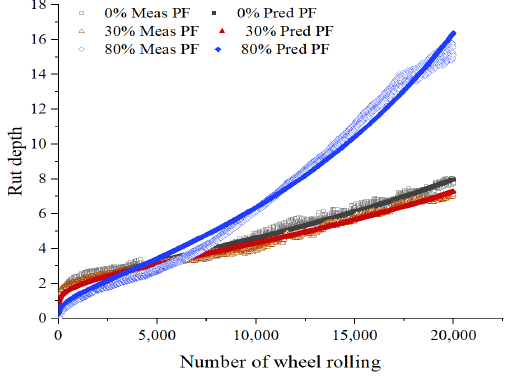
Figure 19. HWTT Curve of PF Asphalt Mixture.